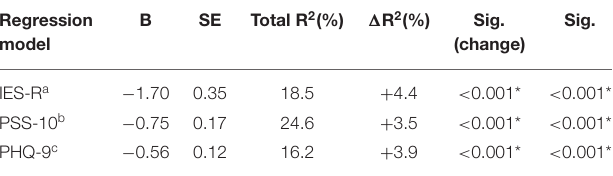
TABLE 3 | Linear regression models on the role of perceived organizational support score (dependent variable) on IES, PSS, and PHQ scores, after adjusting for multiple confounders ( N =